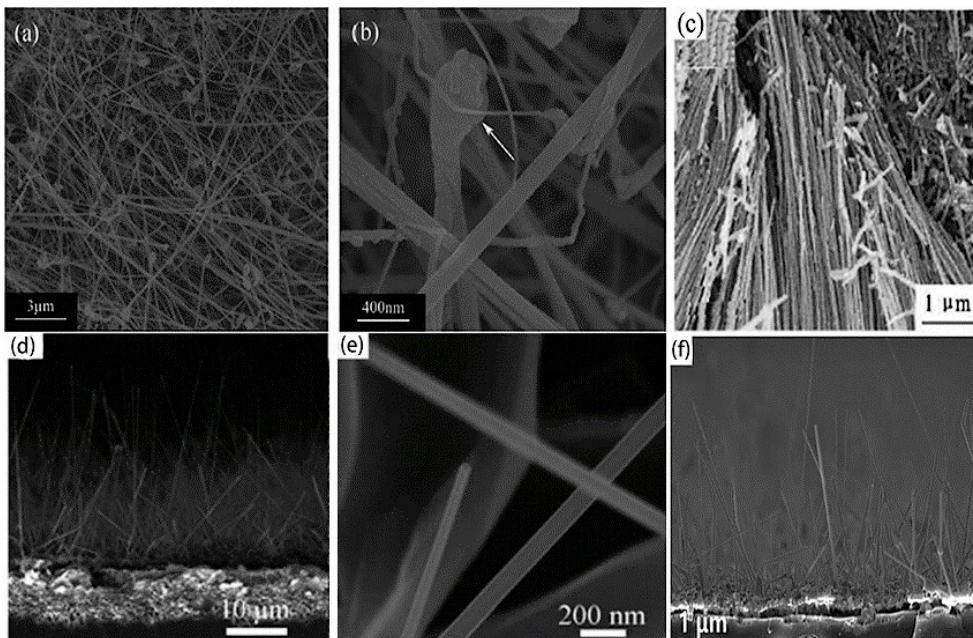
Figure 2. ( a , b ) Typical low-magnification and high-magnification SEM images of the PrB 6 nanowires